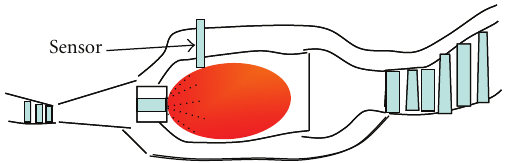
Figure 1: Illustration of combustor and pulsation sensor location.